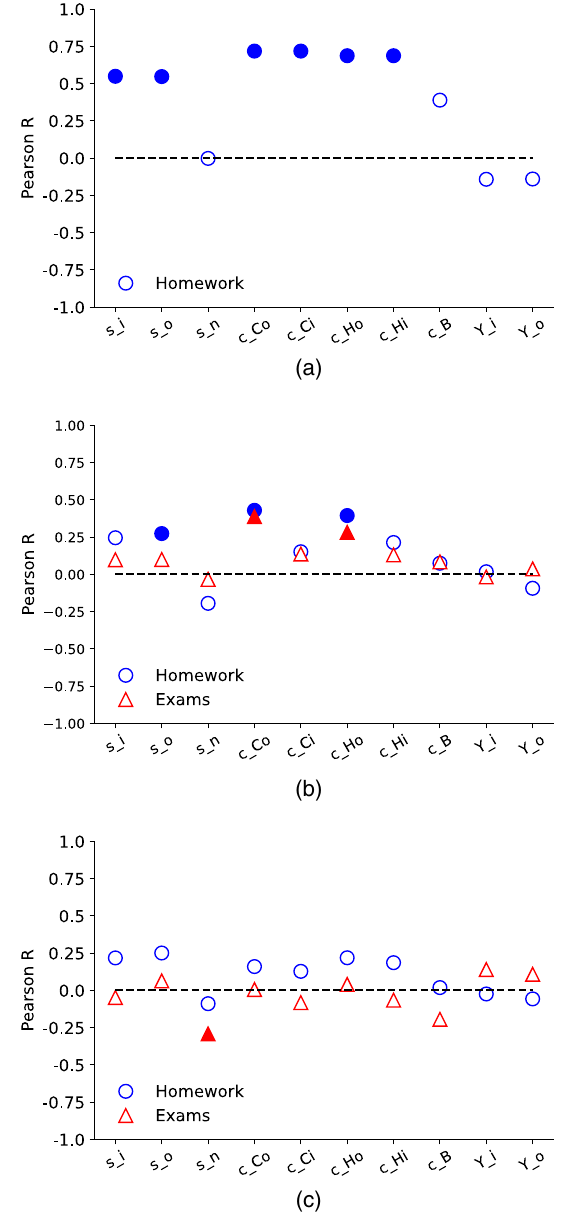
FIG. 6. Correlations between nodal centrality measures and student performance in three pandemic-affected courses. Corre- lations significant at the p < 0 . 05 level are indicated with filled markers. The math methods course at Mines had no exams. (a)